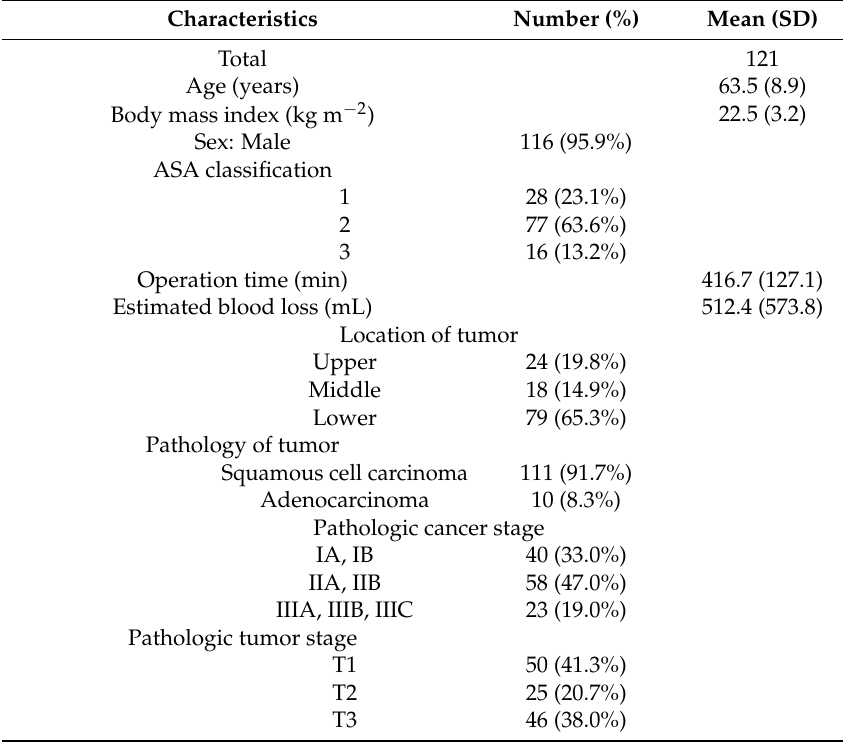
Table 1. Distribution for patient